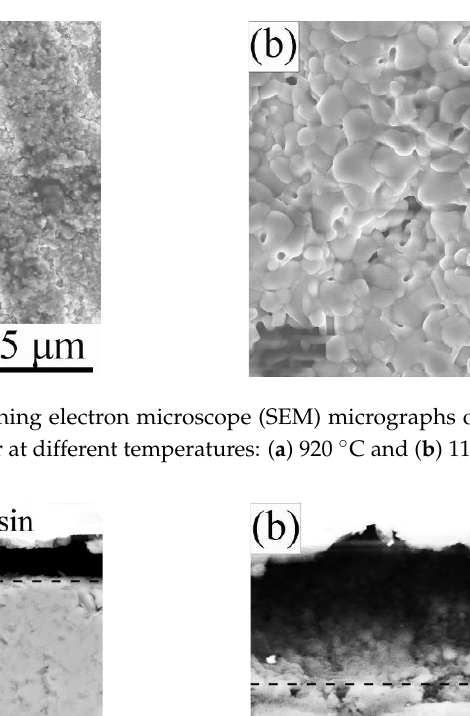
Figure 2. Energy dispersive spectrometer (EDS) patterns of Ti 2 AlC samples quenched in air at dif- ferent temperatures: ( a ) 920 °C and ( b ) 1150 °C.